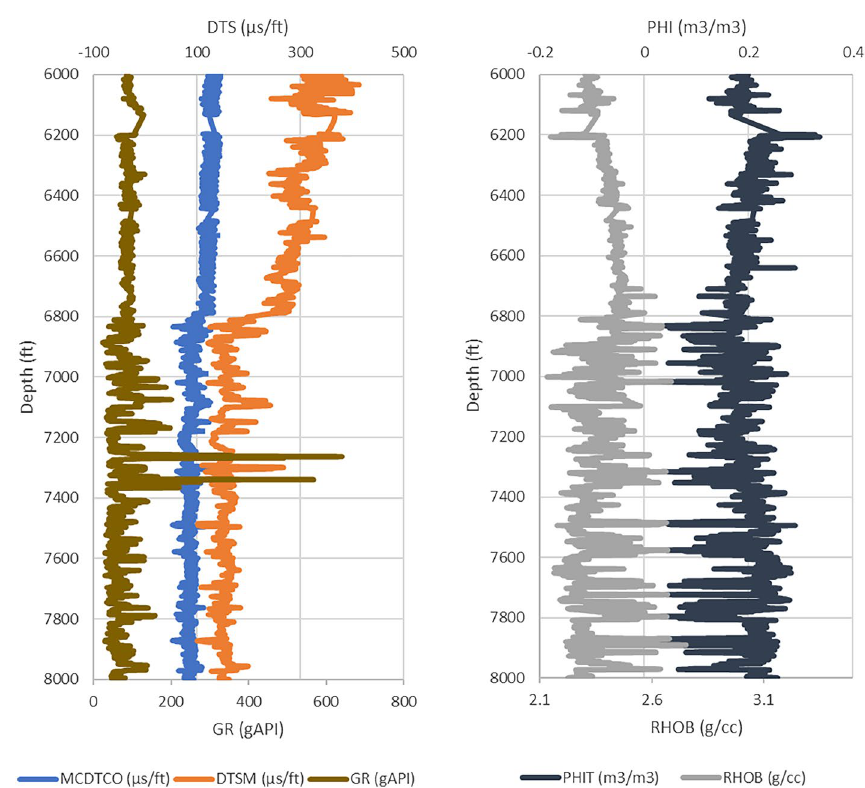
Fig. 7 Available well log data